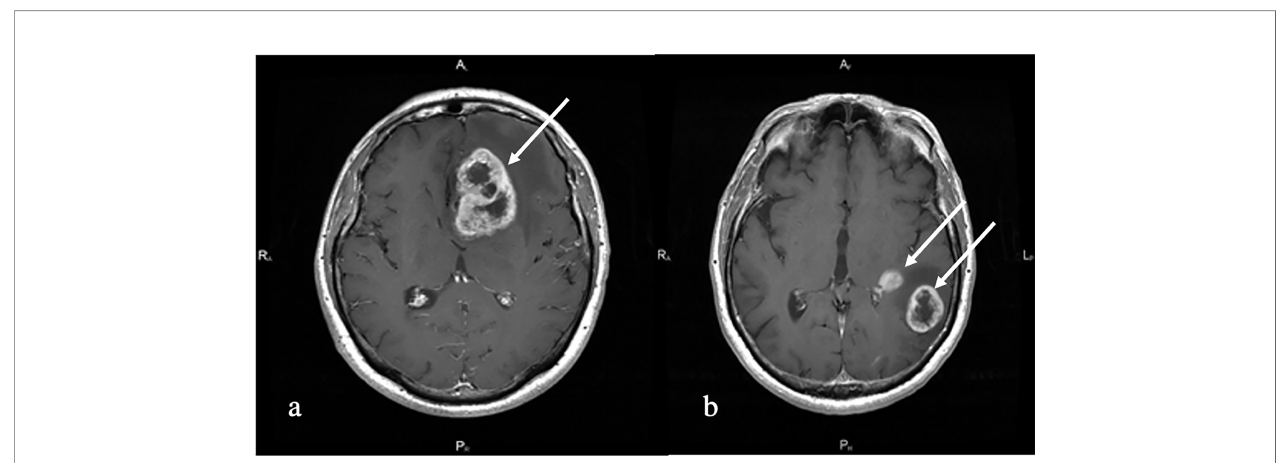
FIGURE 1 | T1 with contrast enhancement. (A) Melanoma metastases (white arrow). Left frontal lobe solitary irregularly contrast-enhancing tumor with central non- enhancing areas and perifocal edema is shown. (B) Multiple primary glioblastoma (white arrows). Left temporal multiple irregularly contrast-enhancing lesions with perifocal edema and non-enhancing central part are